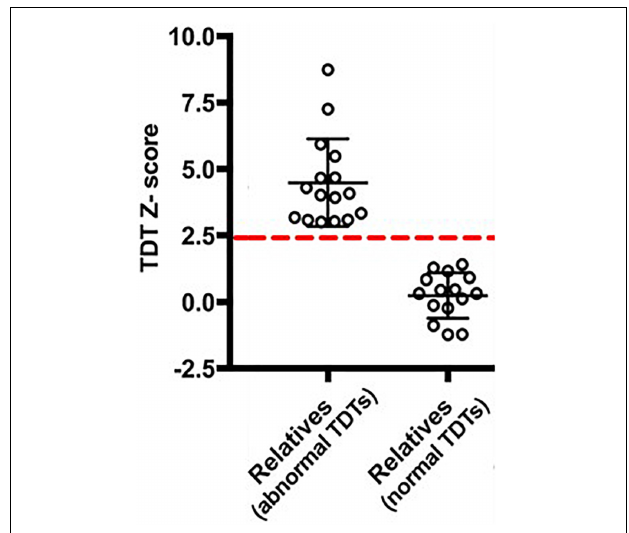
FIGURE 1 | Temporal Discrimination Threshold (TDT) Z -scores of the participants. The dashed-red line denotes a TDT Z -score of 2.5.